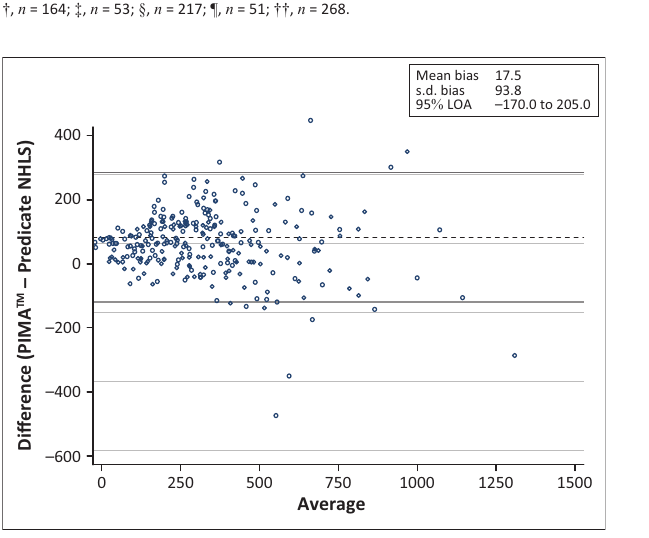
FIGURE 2: Bland–Altman plot PIMA TM point-of-care analyser – National Health Laboratory Services versus the average of PIMA TM point-of-care analyser and National Health Laboratory